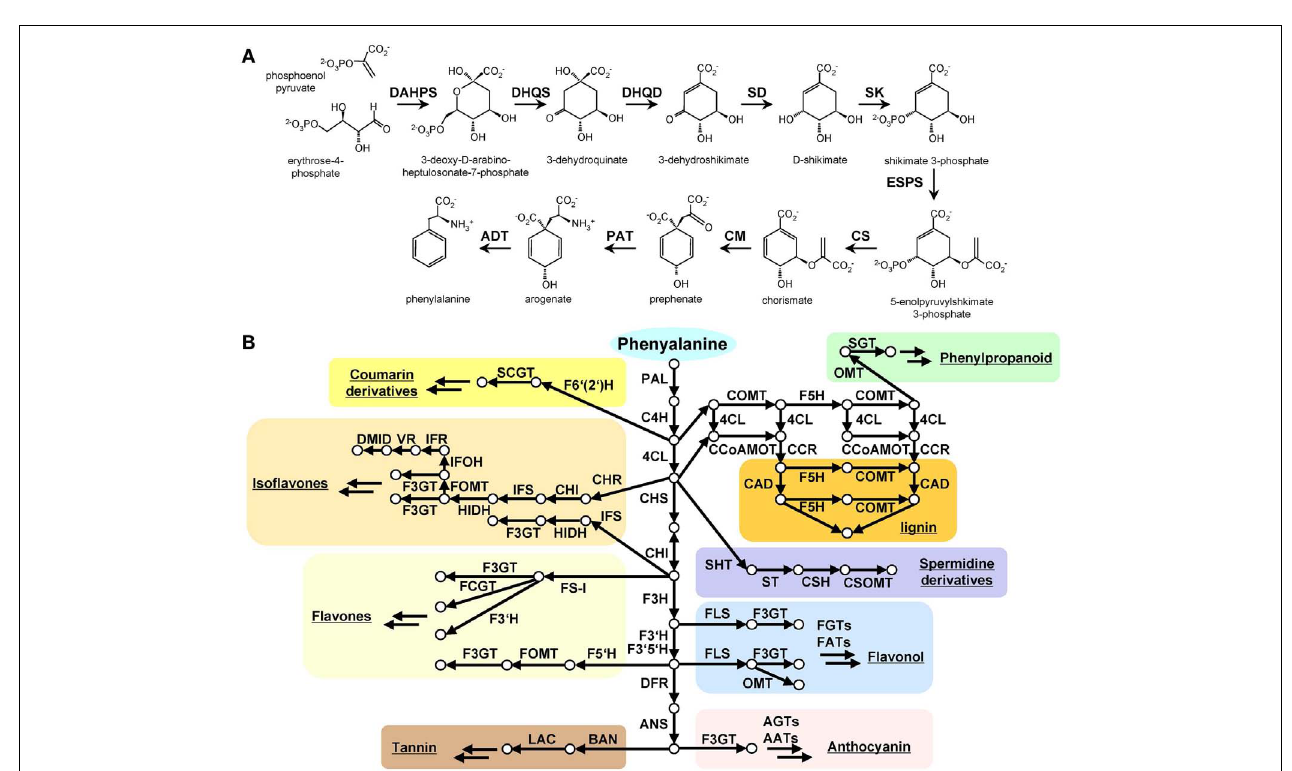
CAD, cinnamoyl-alcohol dehydrogenase; F5H, ferulate 5-hydroxylase; C3H, coumarate 3-hydroxylase; ALDH, aldehyde dehydrogenase;